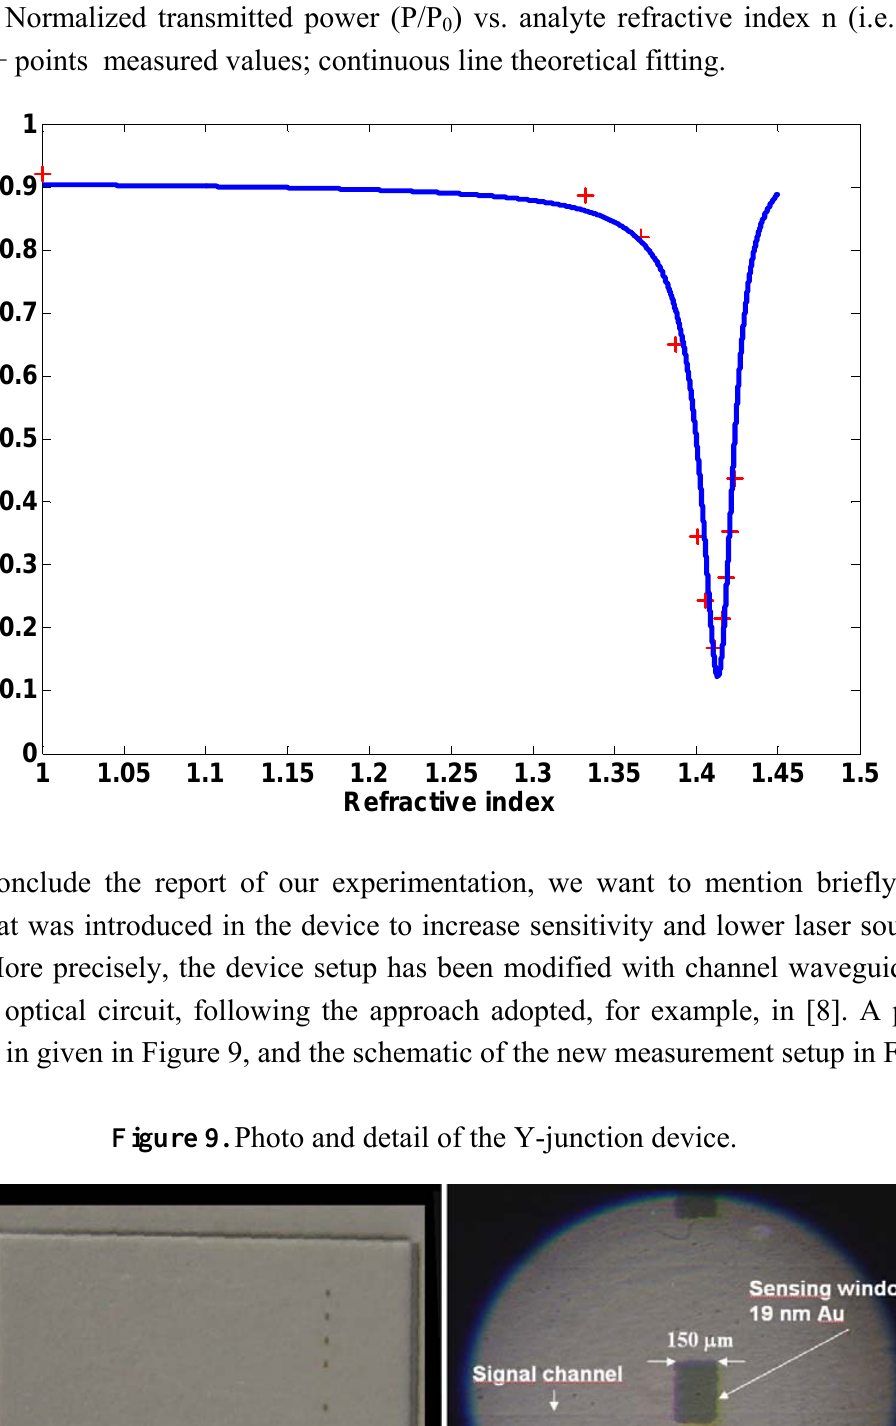
) vs. analyte refractive index n (i.e., % of 0